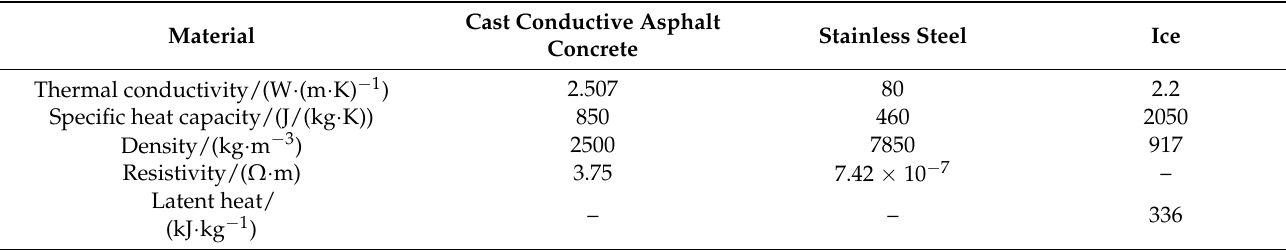
Table 10. Material parameter